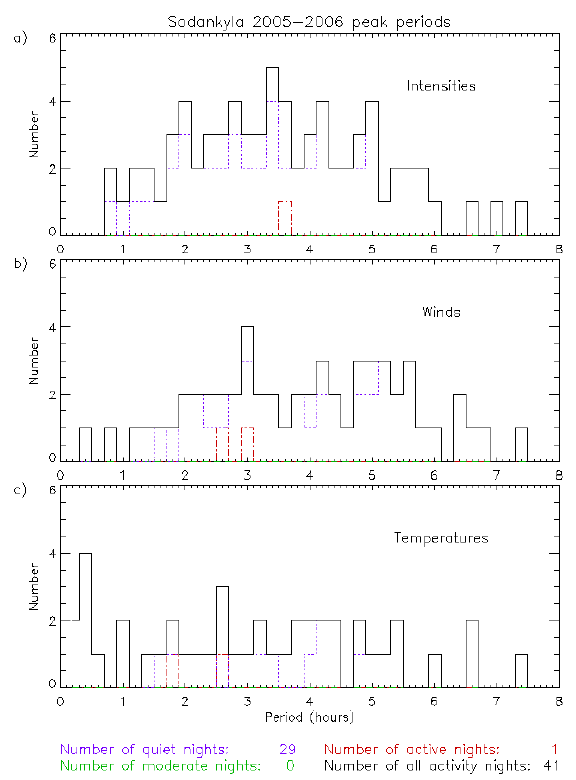
Fig. 5. Histogram of gravity wave periods for all nights from So- dankyl¨a data over the winter season of 2005–2006: (a) intensities, (b) winds, and (c)